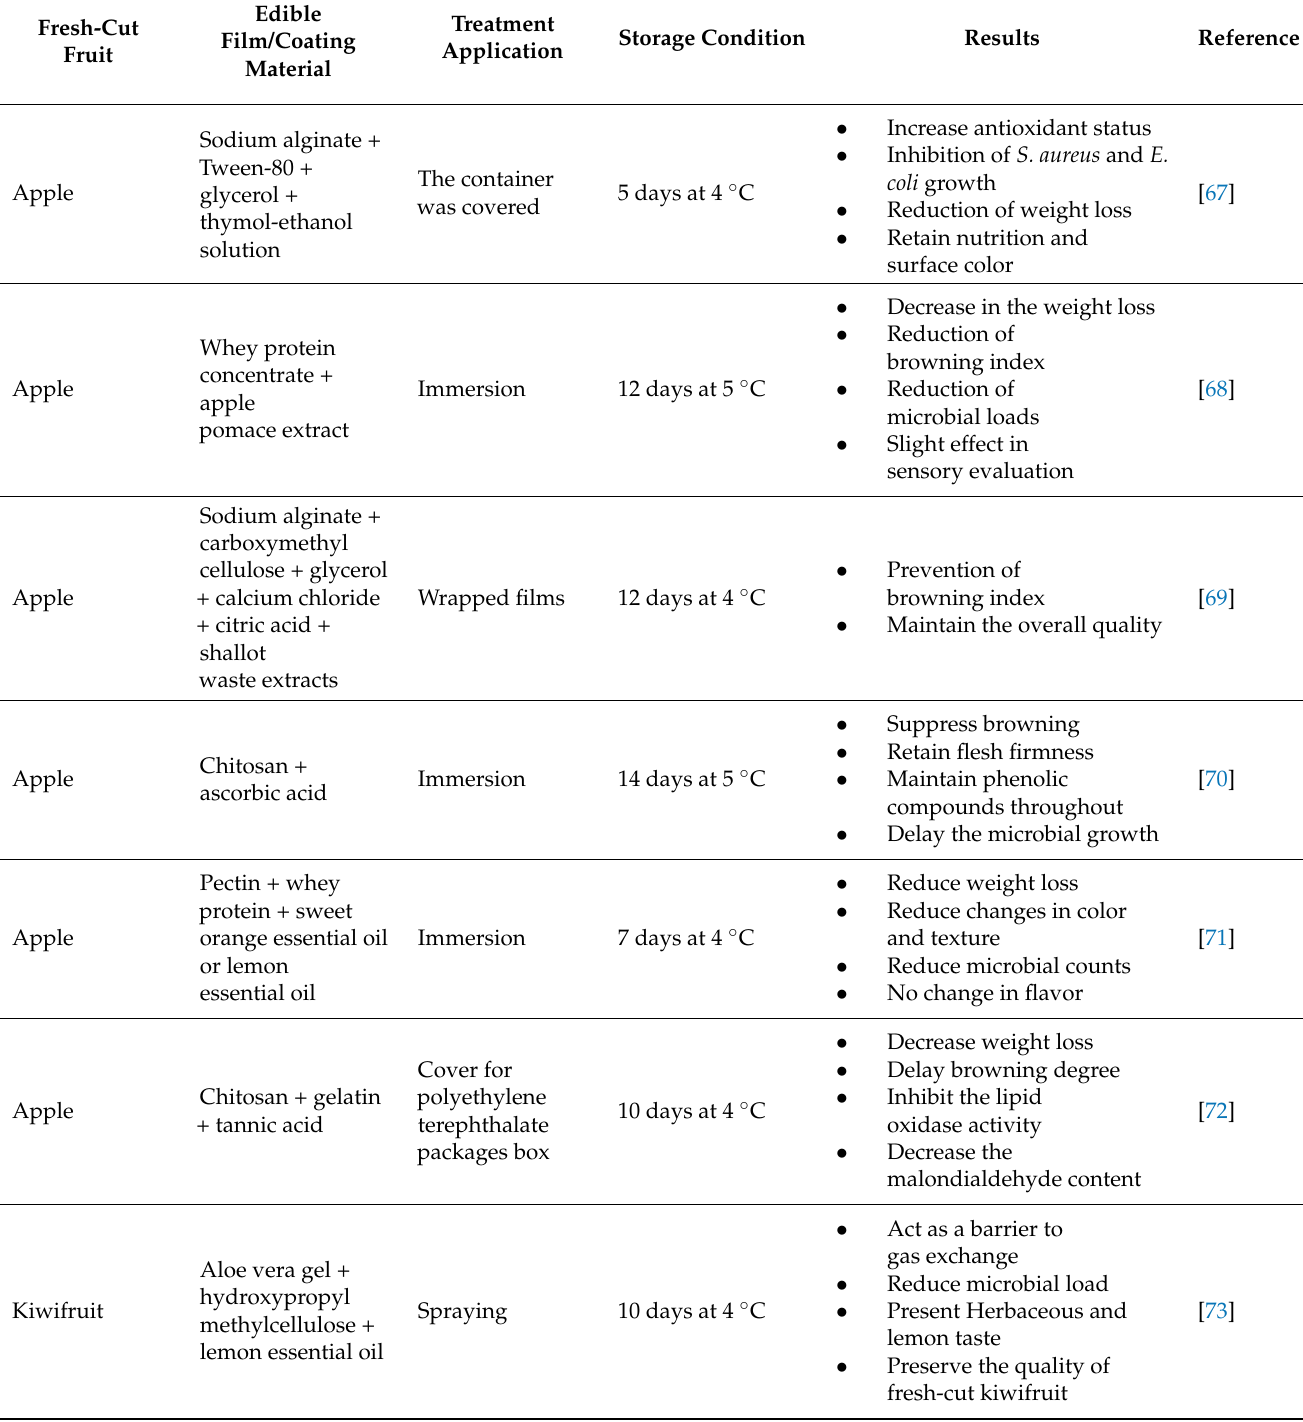
Table 1. Edible coatings and films used to improve fresh-cut fruits’